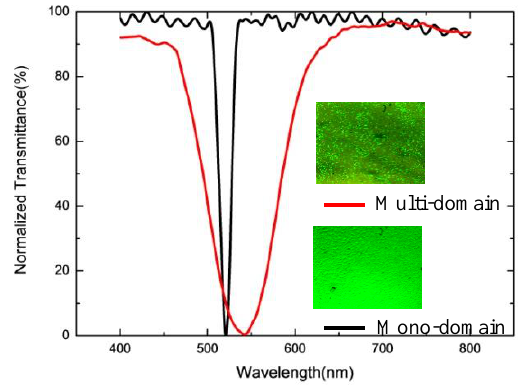
Figure 4. The normalized transmission spectrum of multi-domain blue phase liquid crystal and mono-domain blue phase liquid crystal.